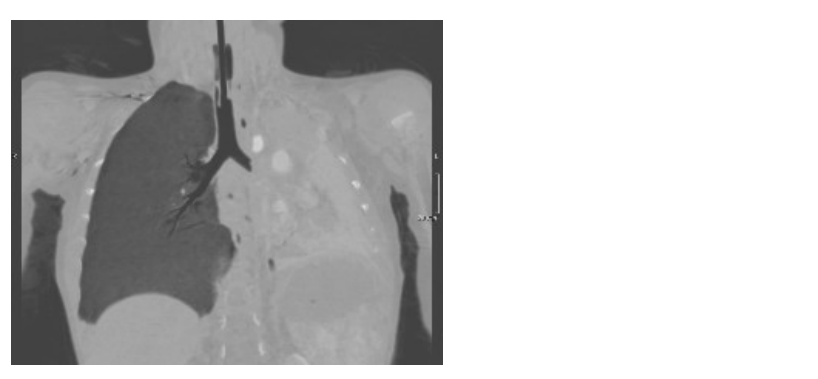
Figure 2. Chest CT scan showing a complete atelectasis of the left lung and an interruption of the main left bronchus.